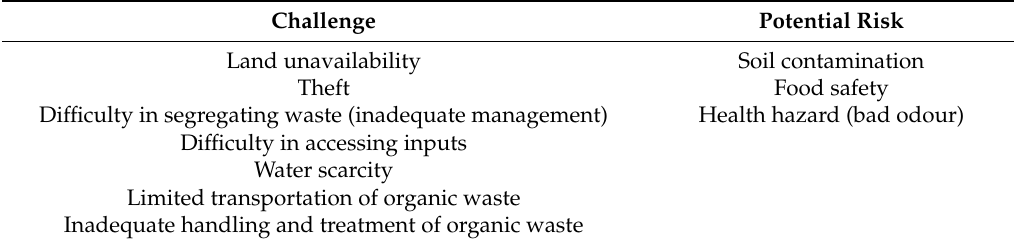
Table 6. A summary of the challenges and potential risks of organic usage in urban agriculture from the qualitative